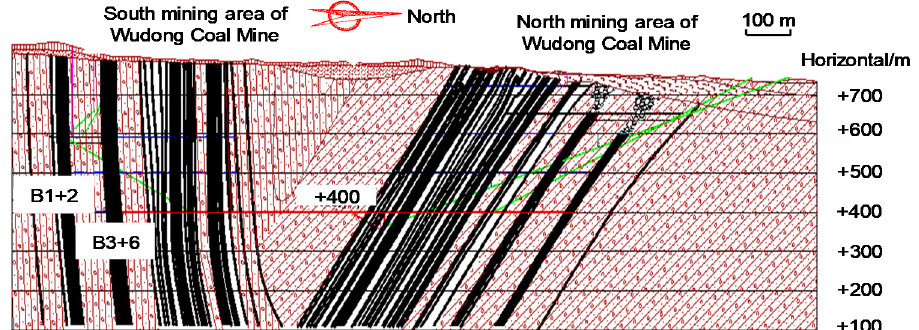
Figure 1. Section view of the coal seams distribution in the North and South area of the Wudong Coal Mine.